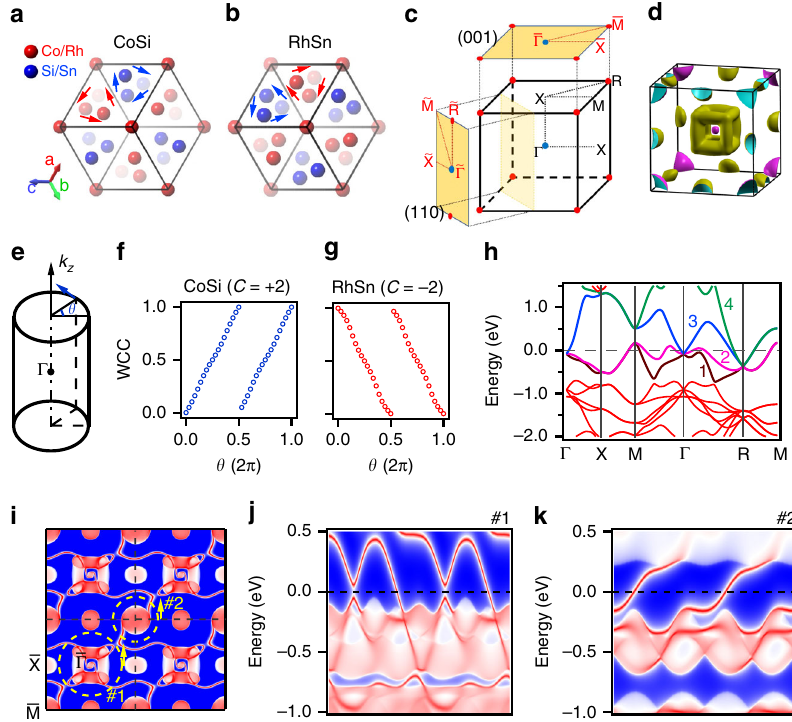
Fig. 1 Reversal of chiral lattices and chiral fermions between CoSi and RhSn. a , b Crystal structures of CoSi ( a ) and RhSn ( b ) in the view of [111] direction. The transparency of the balls indicates the depth of the atomic positions from top to the bottom. The red and blue arrows mark the handedness of the Co/ Rh and Si/Sn helixes, respectively. c Bulk BZ and (001) and (110) surface BZs. The blue and red dots represent the locations of the spin-1 and charge-2 fermions, respectively. d Calculated FSs of RhSn without SOC in the bulk BZ. e WCCs of valence bands around Γ computed from ( r cos θ , r sin θ , 0) to ( r cos θ , r sin θ , 2 π / c ) with r = 0.084 Å − 1 . The evolution of WCCs for CoSi and RhSn is plotted as a function of θ in f and g , respectively. h Calculated bulk band structure of RhSn along the high-symmetry lines without SOC. The numbers mark the four bands related to the chiral fermions. i Calculated (001)- surface states of RhSn without SOC in four surface BZs. The yellow dashed circles and arrows indicate the momentum paths and directions of loops #1 and #2. j , k Surface band structures along loops #1 ( j ) and #2 ( k ) in i